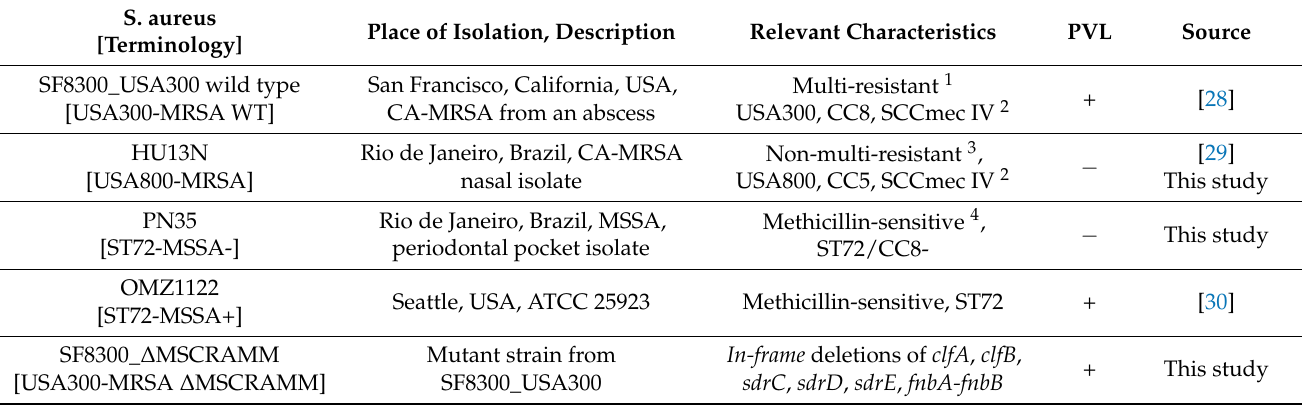
Table 1. S. aureus strains used in this study and the respective terminology throughout the manuscript. S.